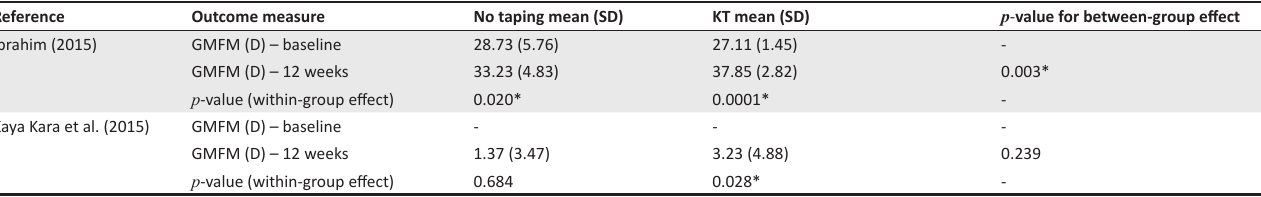
TABLE 7: Effect of kinesiology taping on standing function as determined by Gross Motor Function Measure (D). Reference